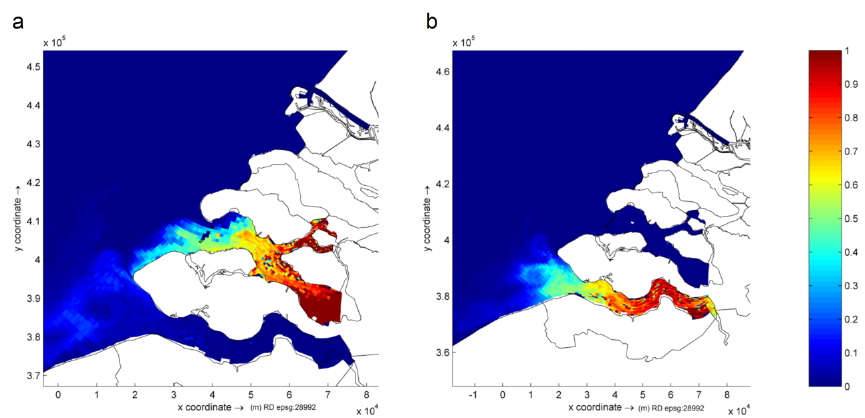
Figure 3. (a) Final concentration of particles (Nm − 3 ) relative to an assumed initial concentration of 1.0 (Nm − 3 ) for the eastern Scheldt July simulation, Delft model; (b) similar for the western Scheldt. Table 2. Percentage of particles from the eastern Scheldt estuary per area after 30 days. Eastern Western Eastern Western Zeebrugge rest Scheldt Scheldt Scheldt mouth Scheldt mouth area North Sea Jan 62.72 0.32 14.78 3.20 0.00 18.98 Feb 63.72